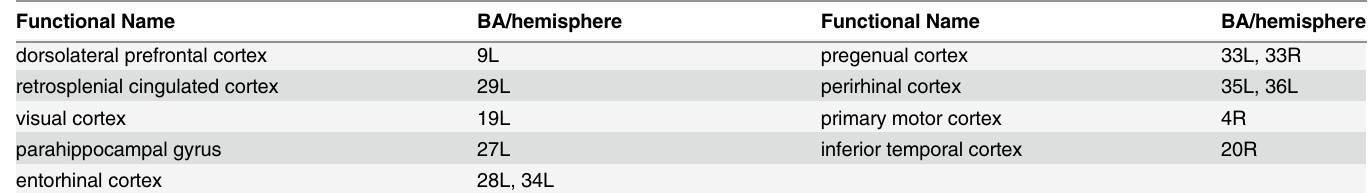
Table 5. Source level clustering coef fi cients increase in the upper alpha band in the WE-IL relative to the WE-IT condition (after multiple comparison permutation tests with corrected p <